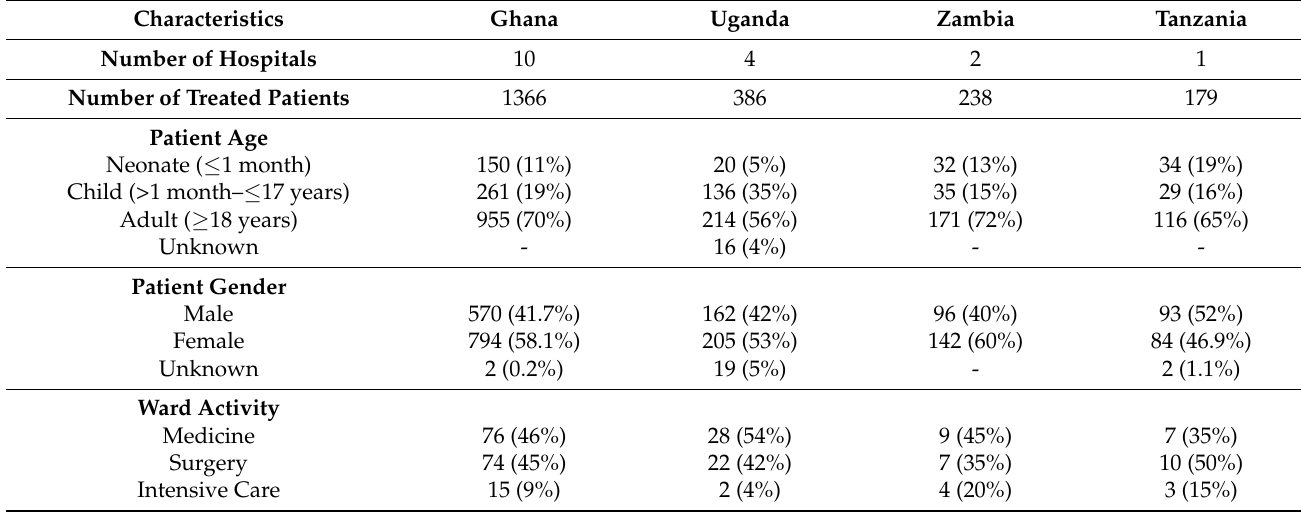
Table 1. Characteristics of wards and patients (treated with at least one antimicrobial) in PPS conducted at 17 hospitals. Characteristics Ghana Uganda Zambia Tanzania